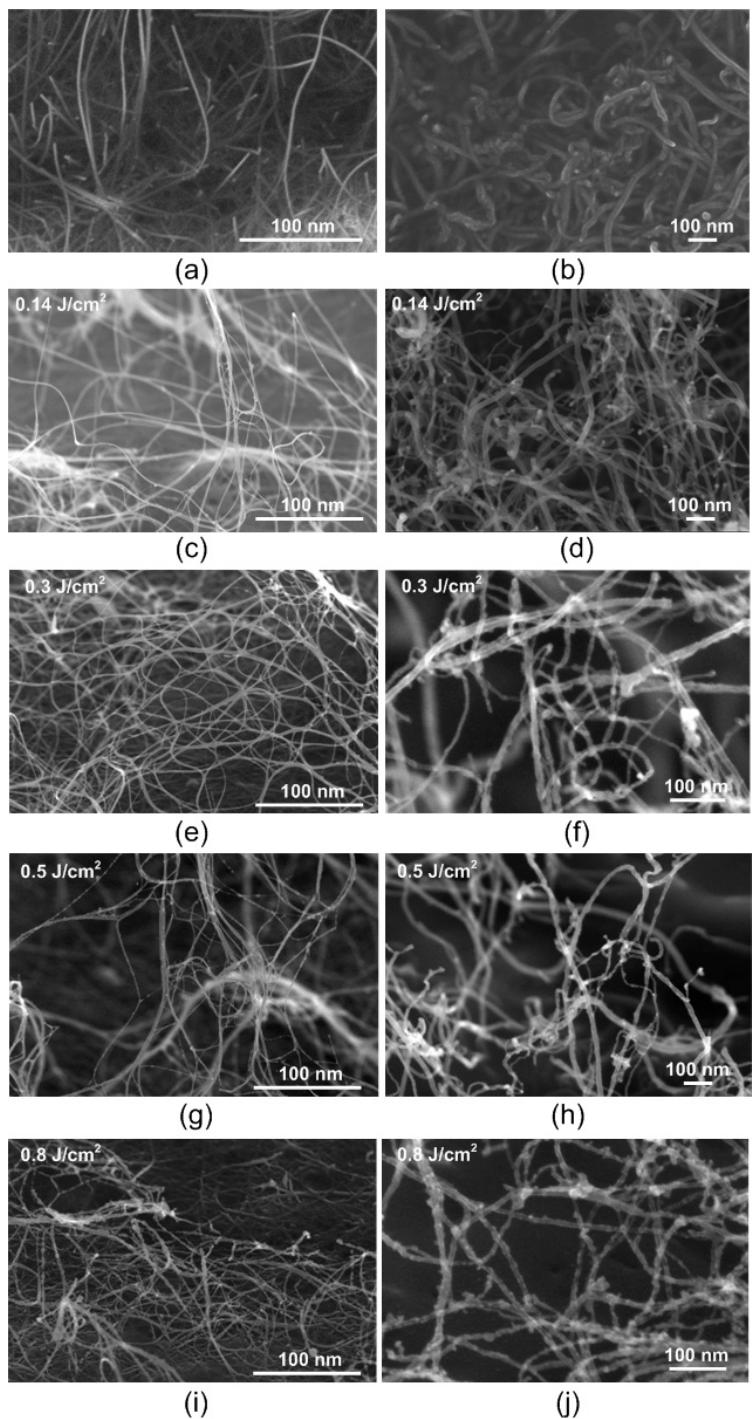
Figure 5. SEM images of ( a , c , e , g , i ) SWCNT and ( b , d , f , h , j ) MWCNT samples ( a , b ) before and ( c – j ) after laser irradiation with different energy densities: ( c , d ) 0.14 J/cm 2 , ( e , f ) 0.3 J/cm 2 , ( g , h ) 0.5 J/cm 2 , ( i , j ) 0.8 J/cm 2 .